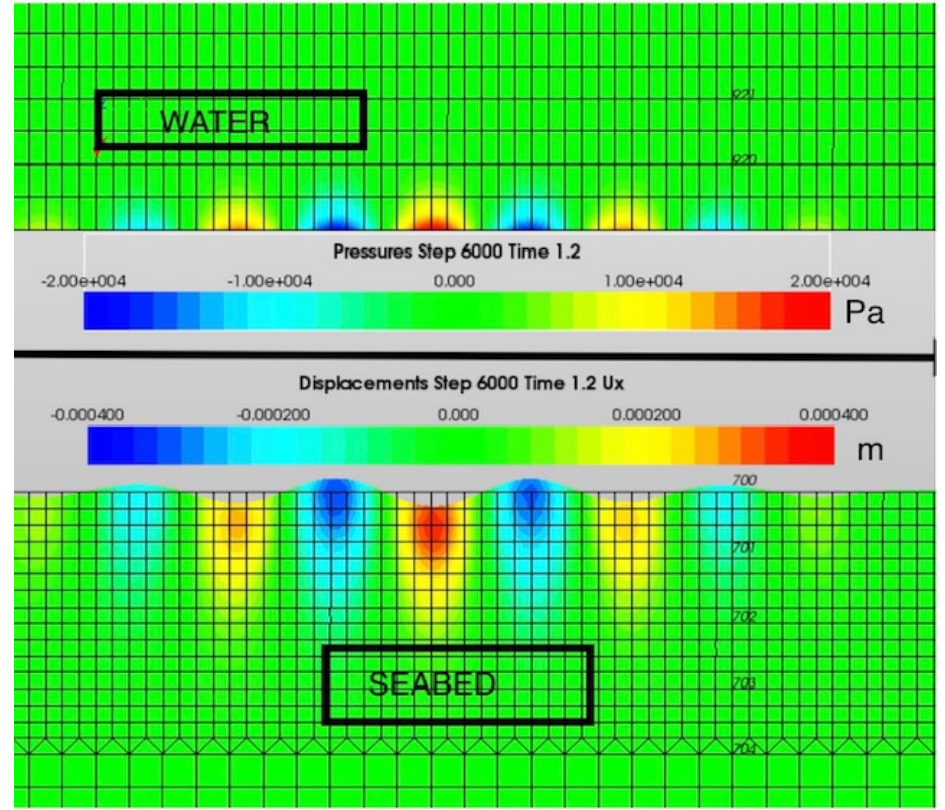
Figure 1. An enlarged view of a section through the FE model shows two parts. The upper section has been processed as a fluid (water) to give a distribution of acoustic pressures. The lower section has been processed to show the deformation of the solid. A colour barcode shows the range of the vertical displacements, from +0.4 mm to − 0.4 mm. The upper section was connected by computation to the lower section to create the acoustic pressure range ± 20 kPa. This snapshot view was at a time of 1.2 s, after 6000 computational time steps had been